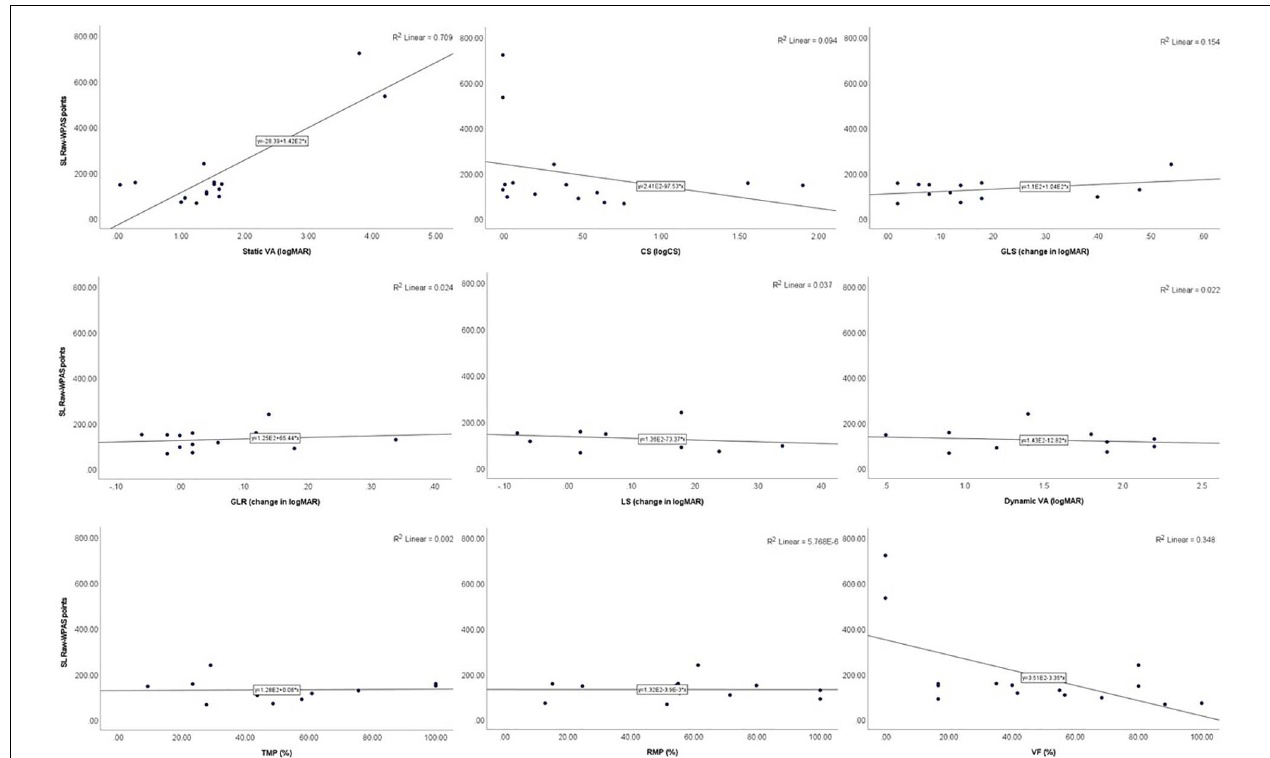
FIGURE 6 | Scatter plots showing the relationships between SL raw-WPAS points and visual functions.